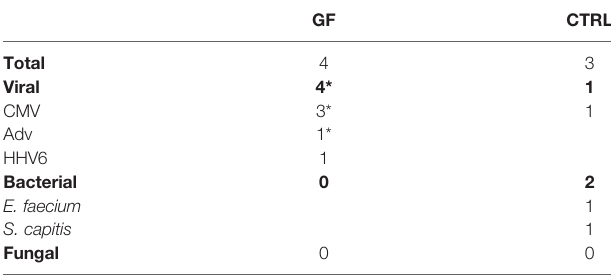
TABLE 2 | Details on infections recorded in the GF and control cohorts during the study